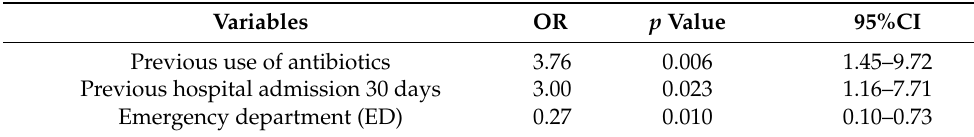
Table 3. Result of logistic regression analysis to evaluate factors associated with CPE carriage on